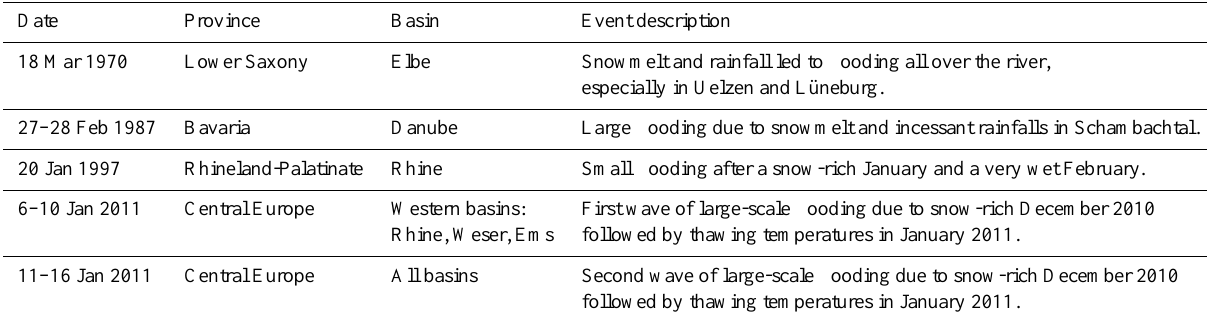
Table 1. Historical RoS events (sources: Wetterchronik, 2001; Kohn et al.,